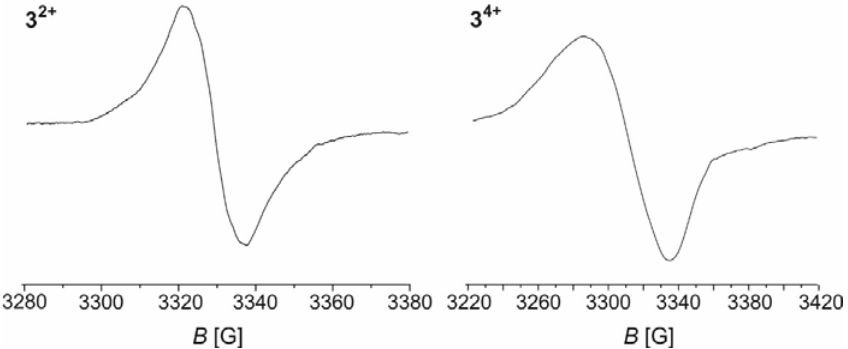
Figure 10. EPR spectra of the di ‐ ( left ) and tetracation ( right ) of macrocycle 3 (CH 2 Cl 2 , r.t.).